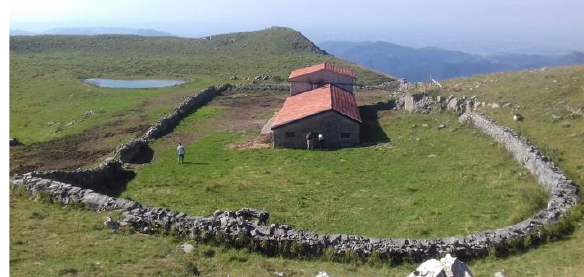
Figure 4. Farmhouse called ‘Malga Due Signore’ in Tavernole sul Mella, Brescia